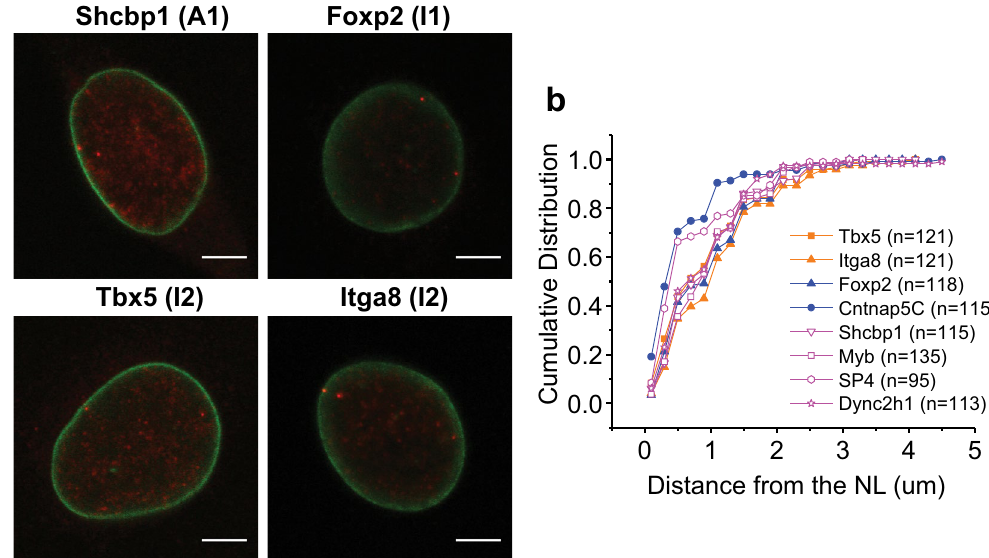
Figure 8. NL genes of different subgroups are localized to the nuclear periphery. ( a ) Representative DNA FISH images of one A1 gene ( Shcbp1 ), one I1 gene ( Foxp2 ) and two I2 genes ( Tbx5 and Itga8 ). FISH signals are shown in red and anti-Lamin B immunofluorescence signals were shown in green. Scale bars: 5 μ m. ( b ) Cumulative frequency distributions of distances between eight NL genes and the NL. A1, I1 and I2 genes were plotted in pink, blue and orange, respectively. Pair-wise Kolmogorov-Smirnov (K-S) tests among six NL genes ( Shcbp1 , Myb , Dync2h1 , Foxp2 , Tbx5 and Itga8 ): P > 0.05 in all cases. Pair-wise K-S test between Sp4 or Cntnap5C and each of the other six NL genes: P < 0.05 in all cases. FISH data of three A1 genes ( Myb , Sp4 and Dync2h1 ) and one I1 gene ( Cntnap5C ) were obtained from our previous study 14